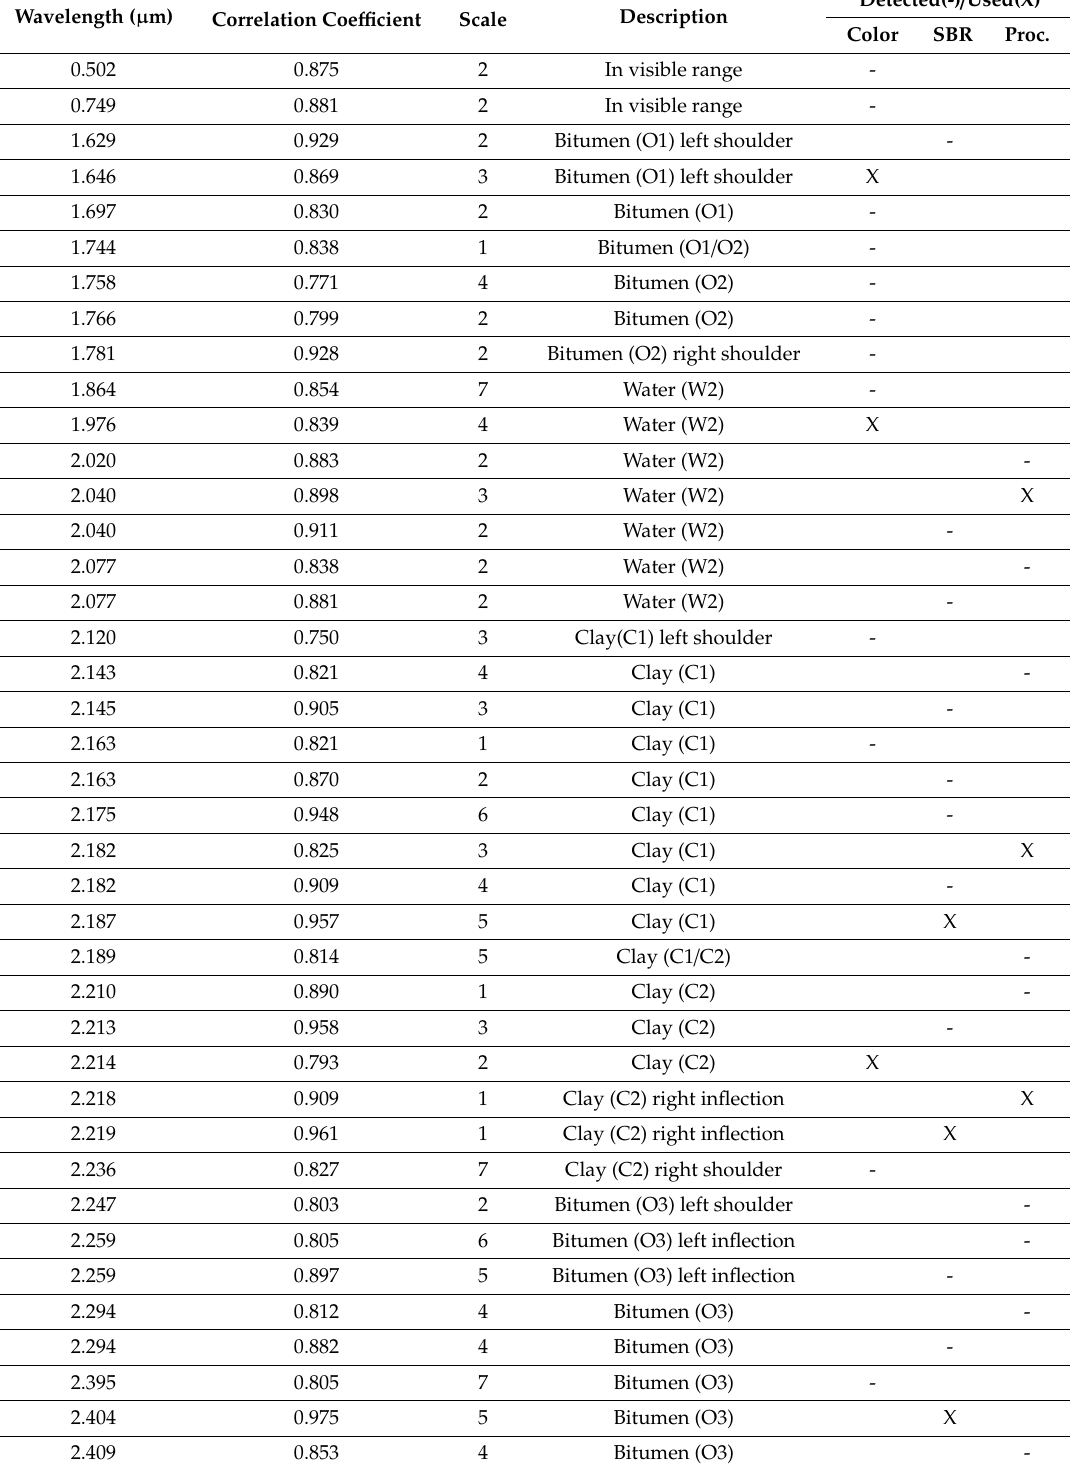
Table 3. List of wavelet spectral features best correlated to froth color, solid / bitumen, and